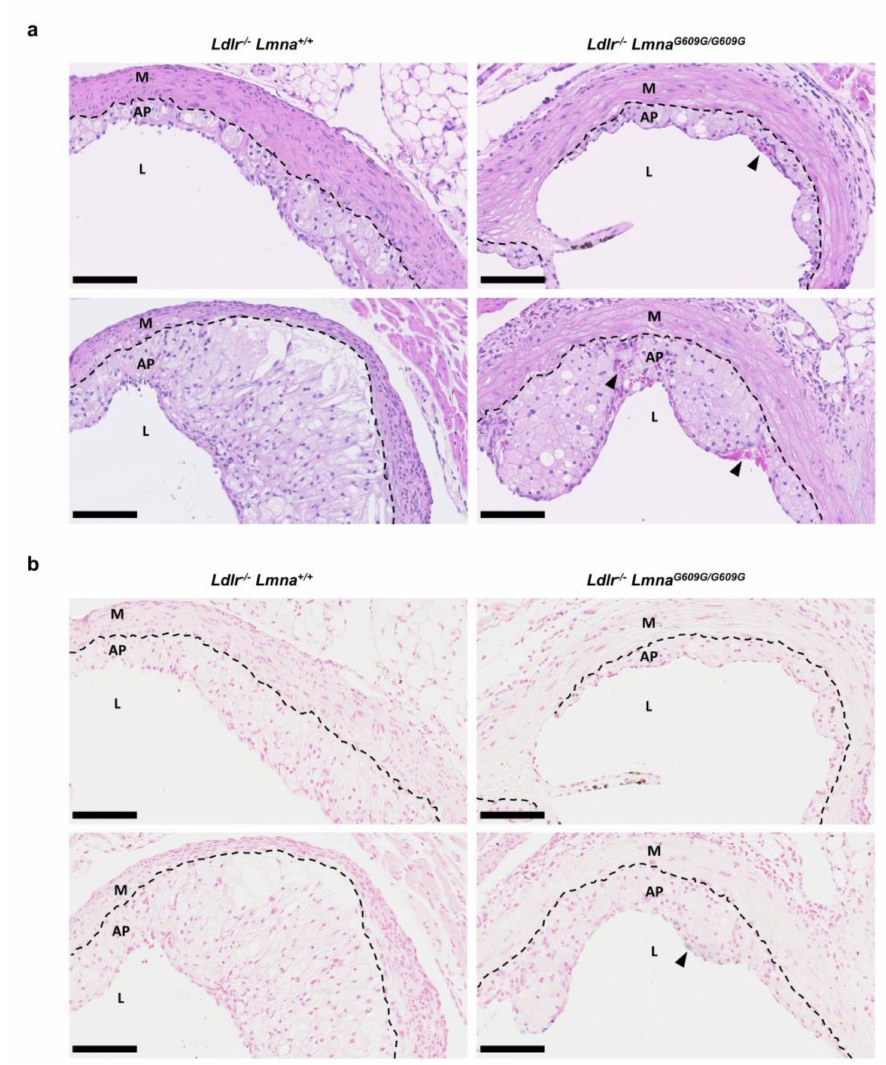
Figure A4. Presence of erythrocytes and iron deposits in atheromas of fat-fed female Ldlr − / − Lmna G609G / G609G mice. Female mice were fed a high-fat diet from eight weeks of age and sacrificed at 16 weeks of age. ( a ) Representative images of aortic root sections of Ldlr − / − Lmna +/+ and Ldlr − / − Lmna G609G / G609G mice stained with hematoxylin–eosin. Black arrowheads indicate erythrocytes. Scale bar, 100 µ m. ( b ) Representative images of aortic root sections of Ldlr − / − Lmna +/+ and Ldlr − / − Lmna G609G / G609G mice stained with Perls Prussian blue. Black arrowheads indicate iron deposits. Scale bar, 100 µ m. Discontinuous black lines mark the separation between the media and atheroma plaques. AP, atheroma plaque; M, media; L,